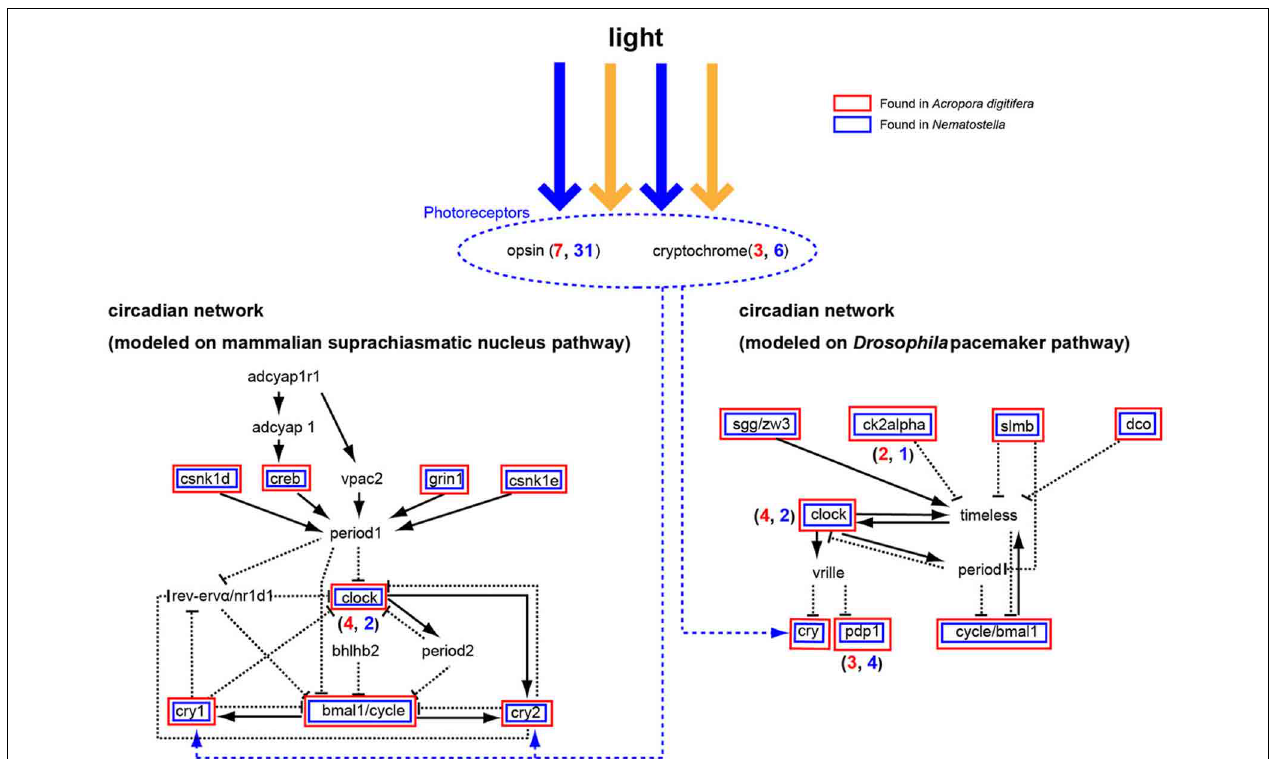
FIGURE 8 | A circadian network modeled on the mammalian suprachiasmatic nucleus pathway (left) and the Drosophila melanogaster pacemaker pathway (right). Some cryptochromes detect blue light and function in the network for ∼ 24h. The Acropora digitifera genome contains seven opsin genes and three cryptochrome